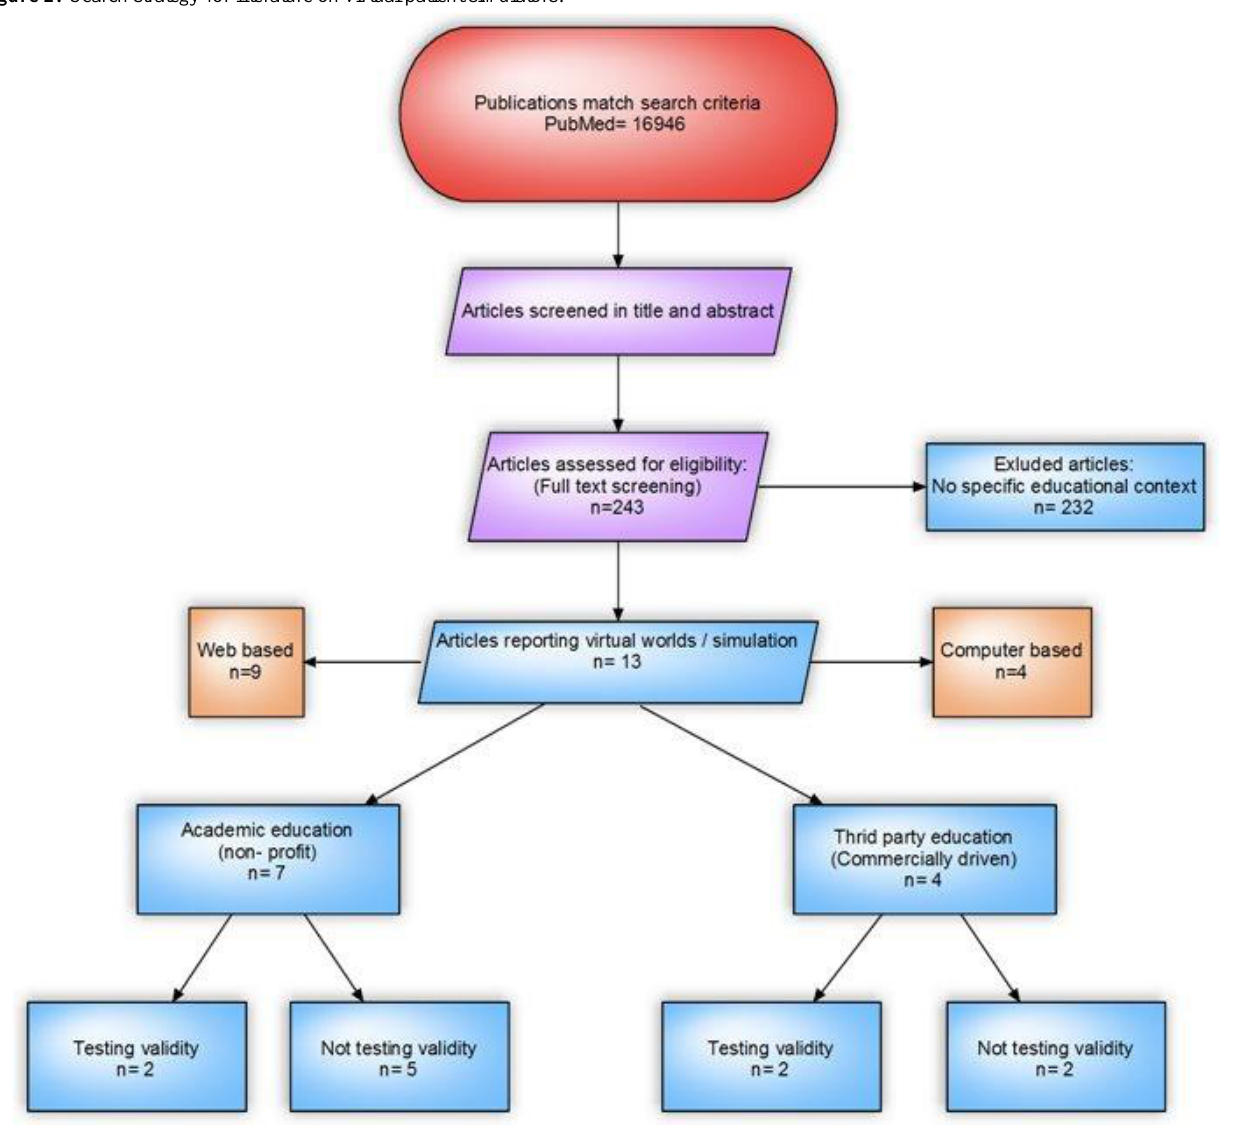
Figure 2. Search strategy for literature on virtual patient